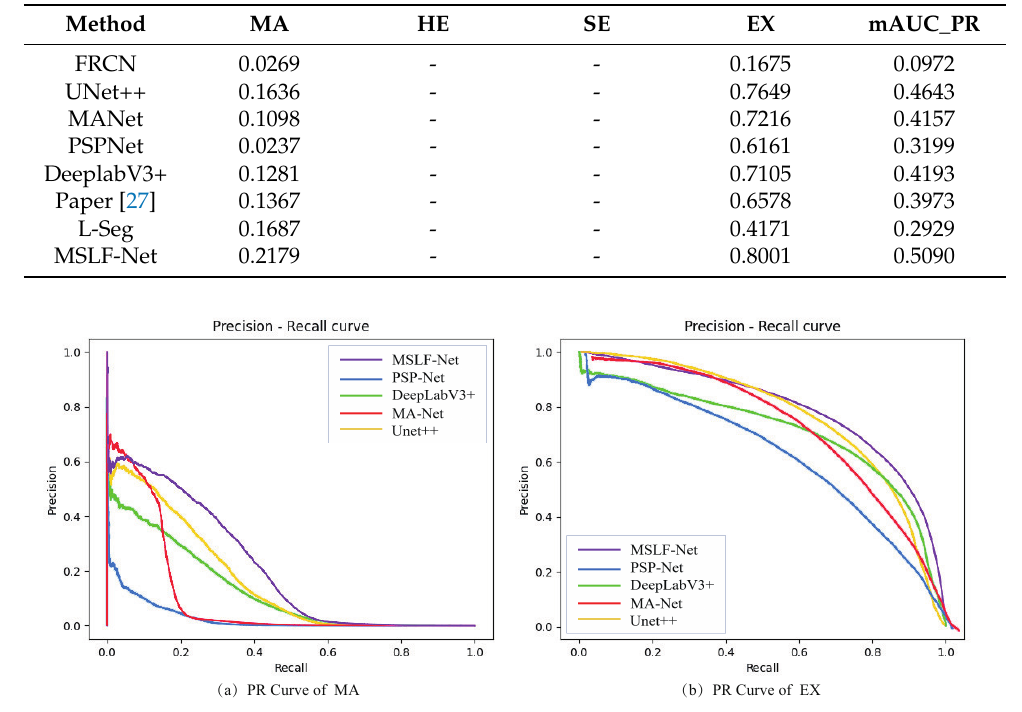
Figure 8. PR curves of MSLF-Net on e_ophtha.